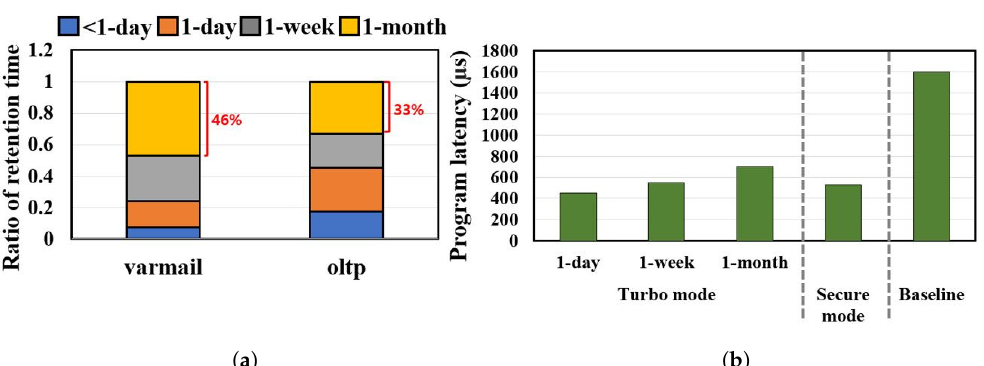
Figure 9. Features of workloads and program latency of each write mode. ( a ) Ratio of retention time within workloads. ( b ) Program latency of write